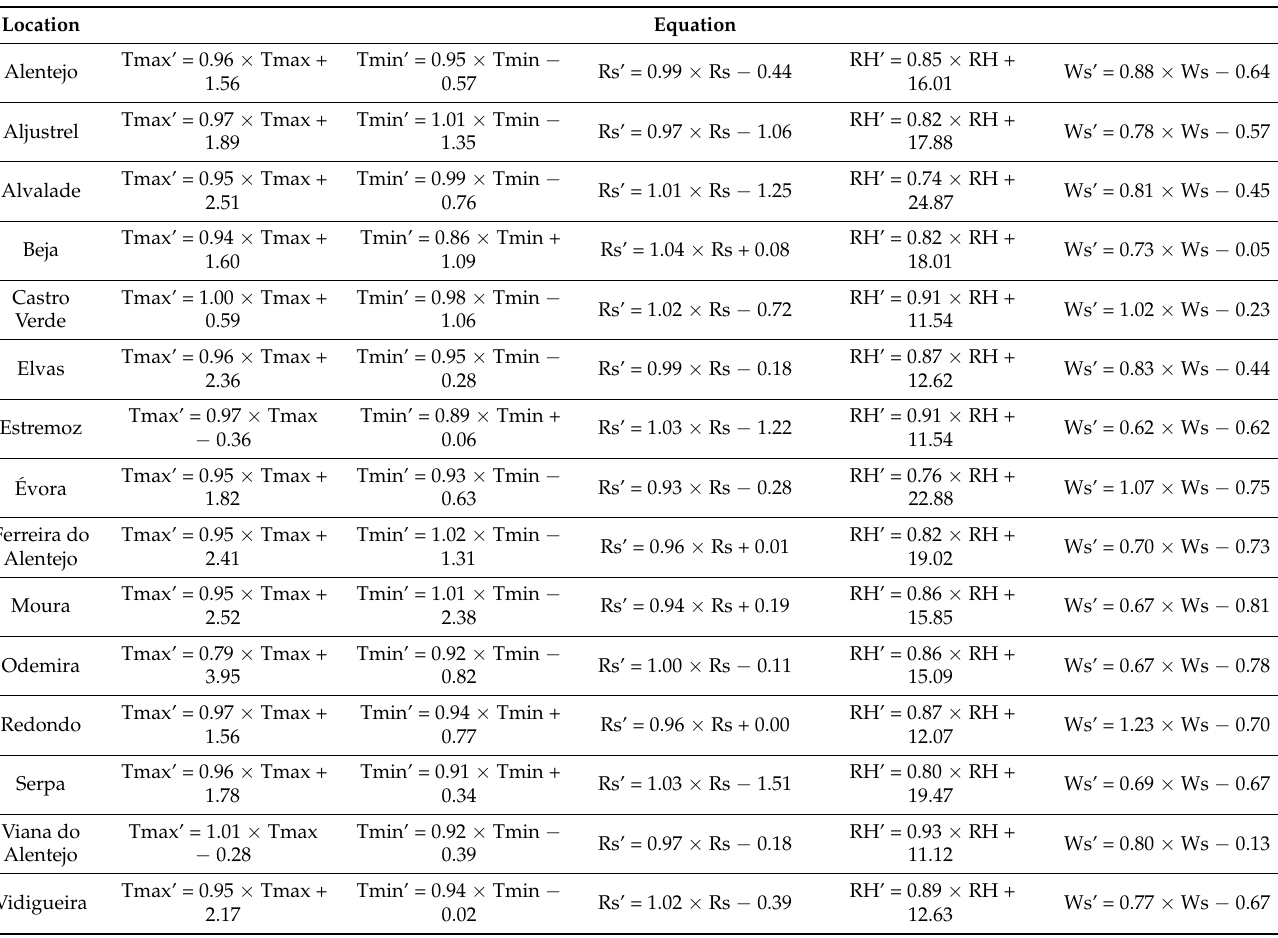
Table 3. Calibrated and validated bias correction equations for NASA POWER maximum (Tmax) and minimum (Tmin) temperatures, solar radiation (Rs), mean relative humidity (RH) and mean wind speed